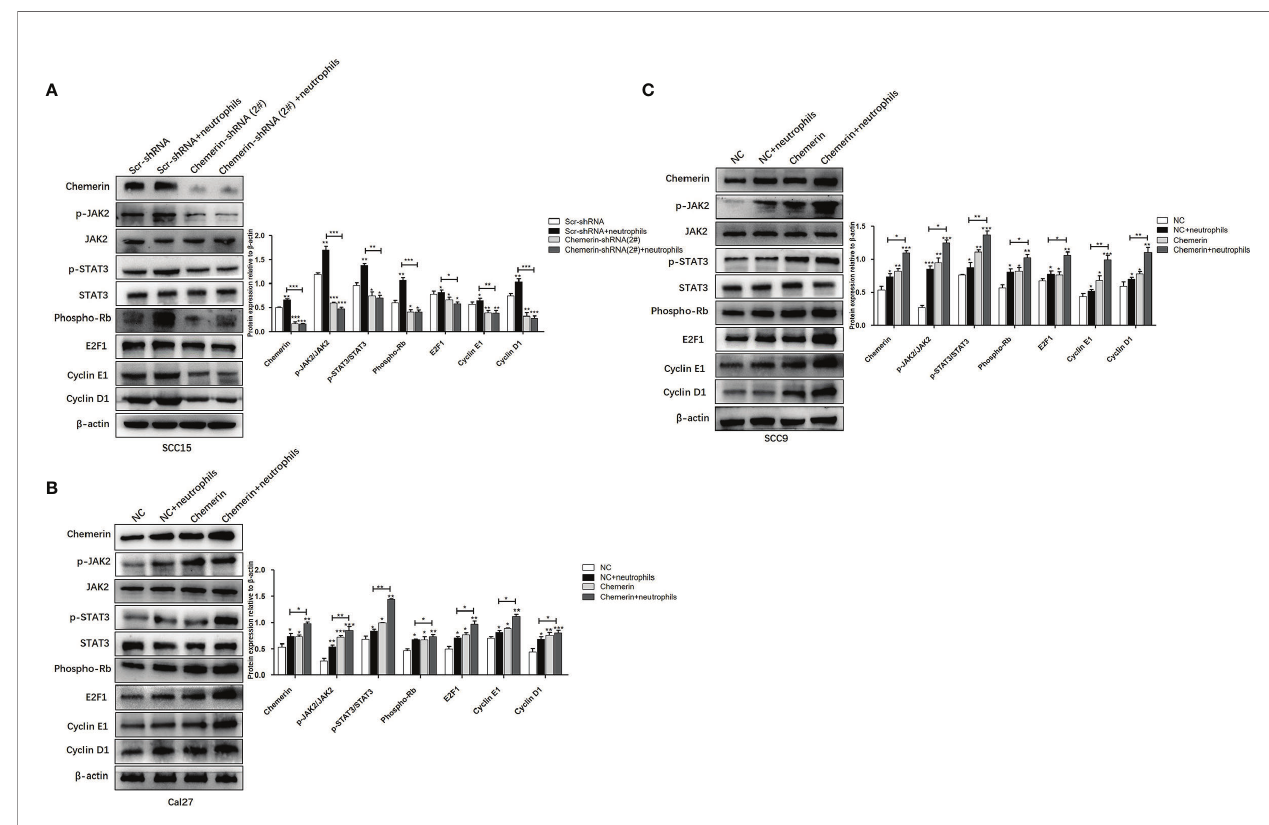
FIGURE 7 | Neutrophils activate the JAK2/STAT3 signaling pathway in OSCC cells through Chemerin. (A) The levels of JAK2, p-JAK2, STAT3, p-STAT3, Phospho- Rb, E2F1, CyclinE1, CyclinD1 protein of SCC15 in the Scr-shRNA, Scr-shRNA + neutrophils, Chemerin-shRNA (2#), and Chemerin-shRNA (2#) +neutrophils groups. (B, C) The levels of JAK2, p-JAK2, STAT3, p-STAT3, Phospho-Rb, E2F1, CyclinE1, CyclinD1 protein of Cal27 and SCC15 in NC, NC + neutrophils, Chemerin, and Chemerin + neutrophils groups. All data were presented as mean ± SD. All the experiments were repeated three times, each performed in triplicates (* P < 0.05; ** P < 0.01; *** P <